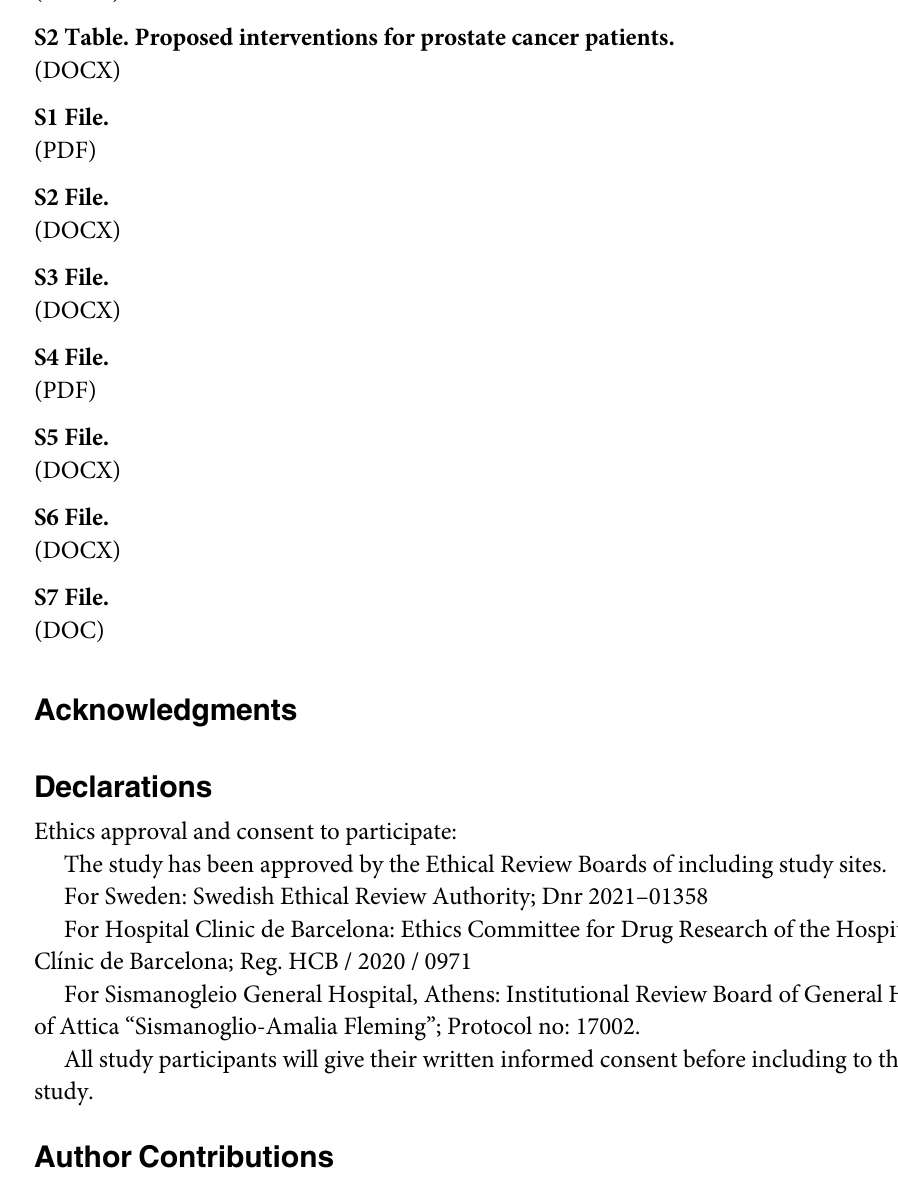
S1 Table. Proposed interventions for breast cancer patients. S2 Table. Proposed interventions for prostate cancer